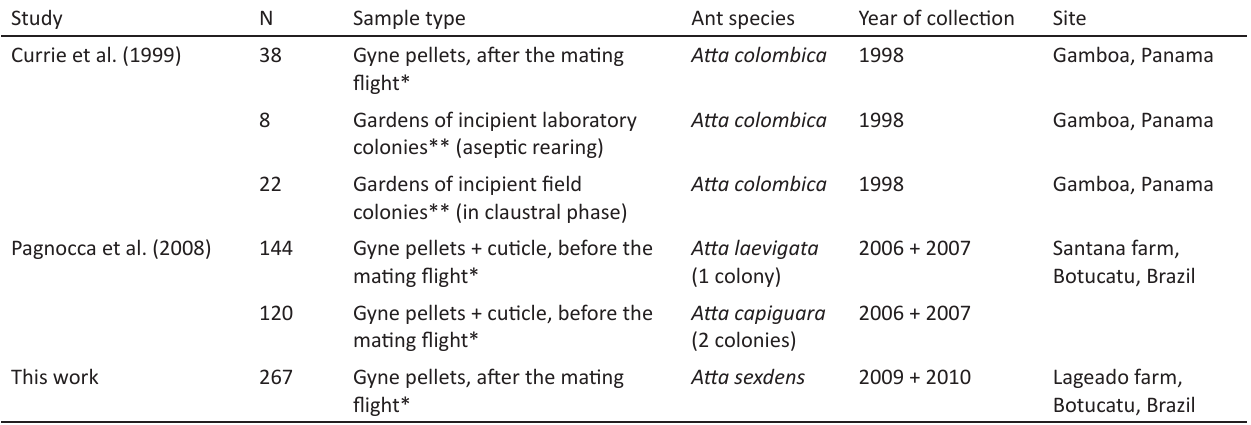
Table 1 . Studies involving the isolation of filamentous fungi from leaf-cutting ants during the mating flight period. Study